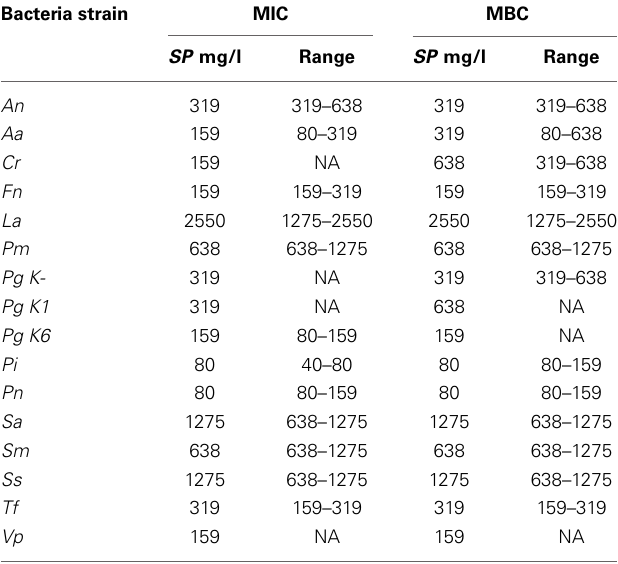
Table 3 | MICs and MBCs of Ardox-X ® technology for the 16 strains studied, expressed as sodium perborate (SP) concentration in the compound.